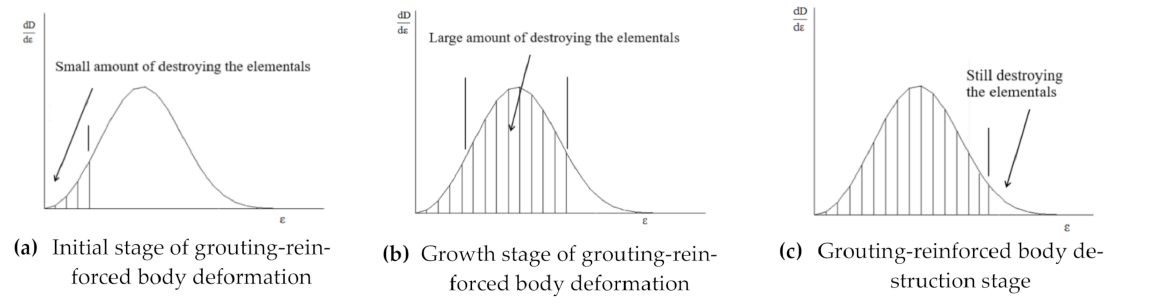
Figure 2. The damage rate variation function of